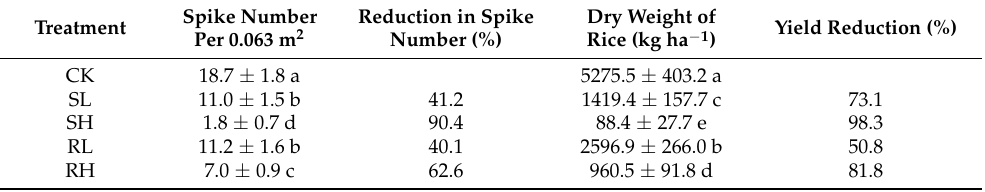
Table 1. Effects of two eared redstem biotypes on yield (mean ± standard error) of paddy rice in the greenhouse at 141 DAS. The letters L and H refer to low and high eared redstem densities, respectively. The letters S and R refer to BSM-susceptible and BSM-resistant eared redstem biotypes, respectively. CK is the control in which only rice was planted. Different letters within columns indicate significantly different means ( p <